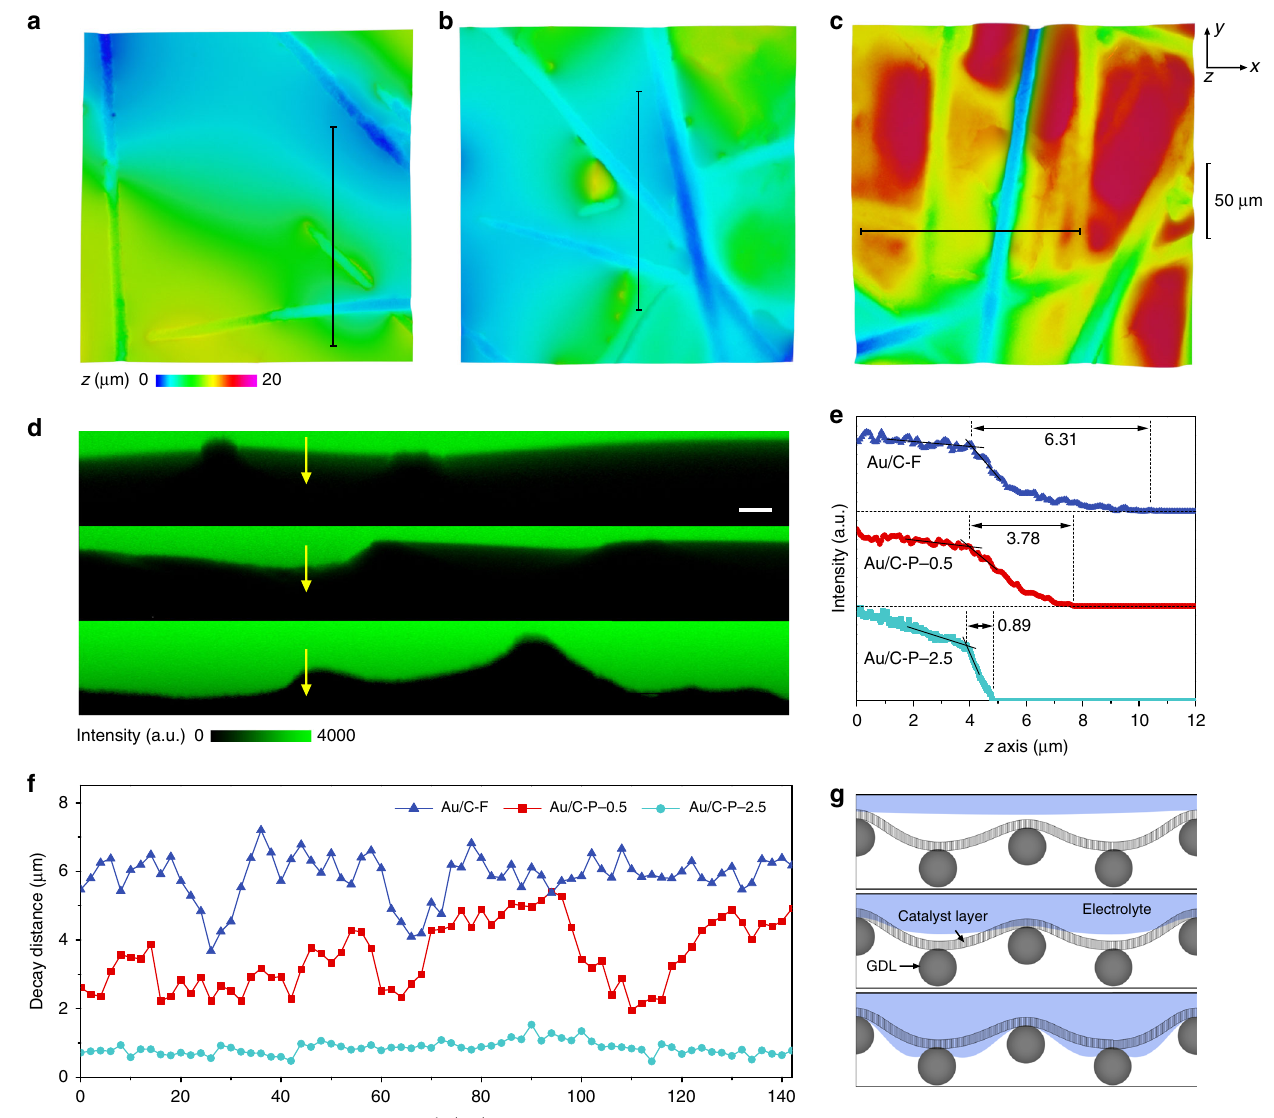
Fig. 3 Characterization of gas – liquid – solid interfaces. a – c Confocal 3D reconstruction images of Au/C-F, Au/C-P-0.5 and Au/C-P-2.5, respectively. d Cross-sectional fl uorescence images scanned from labelled regions (black lines) in ( a – c ), scale bar: 10 μ m. From top to bottom are Au/C-F, Au/C-P-0.5 and Au/C-P-2.5, respectively. e Corresponding z axis fl uorescence intensity line scans of labelled regions (yellow arrows) in ( d ). f Statistics of fl uorescence decay distance from entire area of the cross-sectional fl uorescence images in ( d ). g Schematic illustration of interfacial structures of Au/C-F (top), Au/C- P-0.5 (middle) and Au/C-P-2.5 (bottom), respectively. Source data are provided as a Source data fi